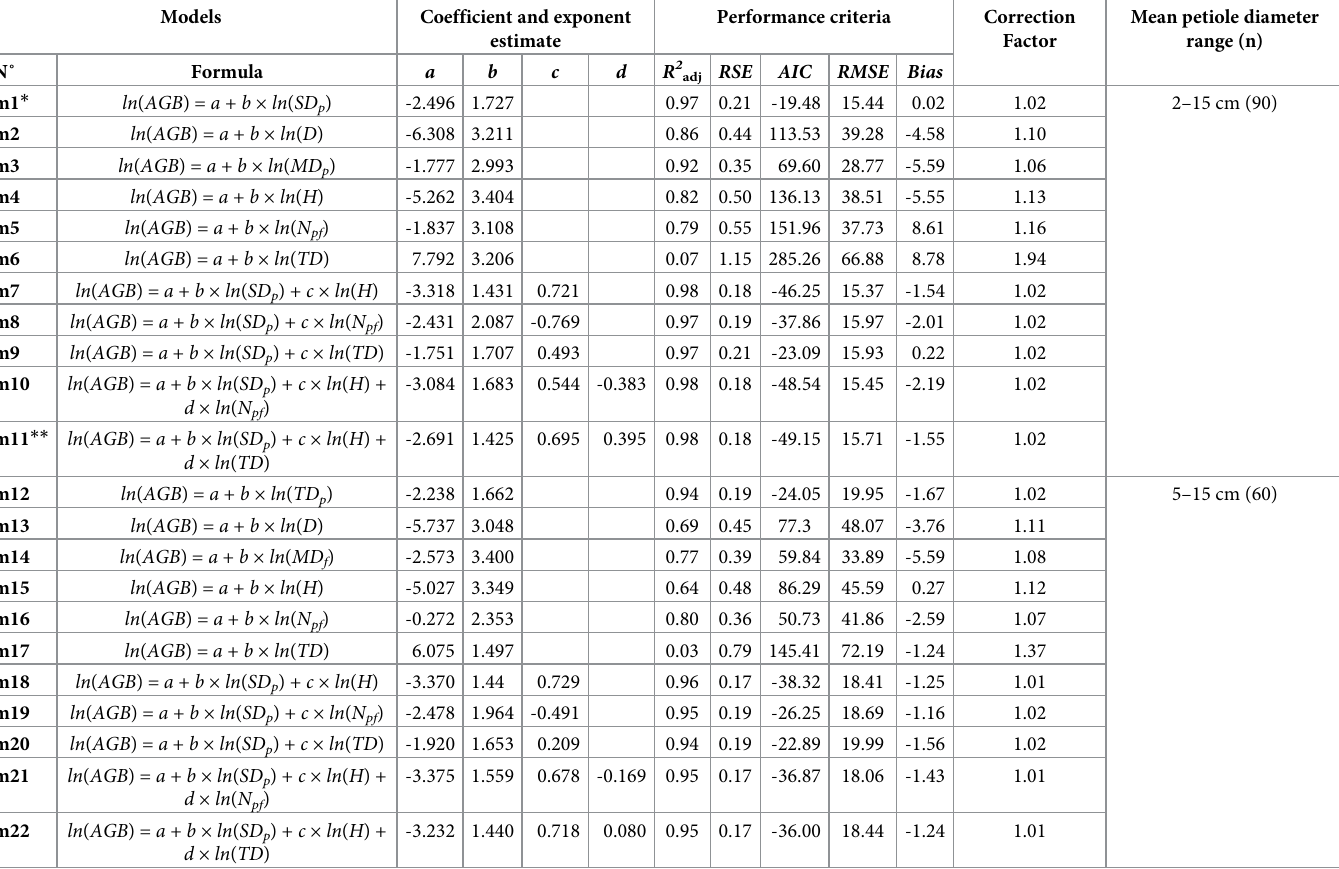
Predictor variables used in the equations are total palm height ( H ; m), stem base diameter ( D ; cm), total petiole diameter ( TD number of palm fronds ( N pf ) and tissue density ( TD ; g cm -3 ). Single asterisk ( * ) indicates the best performing single predictor variable model and double asterisks ( ** ) indicates the best performing multiple predictor variable